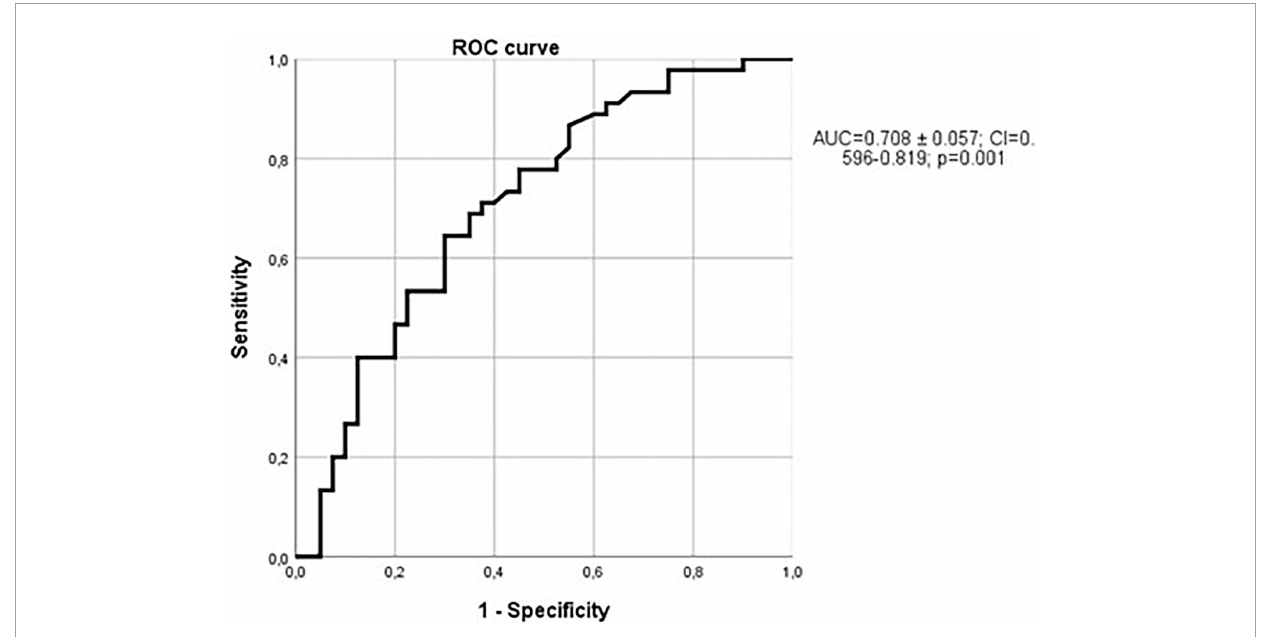
FIGURE11 Relationship between sclerostin and cella media values over the median in patients with vascular calcifications. ROC curve with an AUC = 0.708 ± 0.057; (95% CI = 0.596–0.819); p = 0.001.